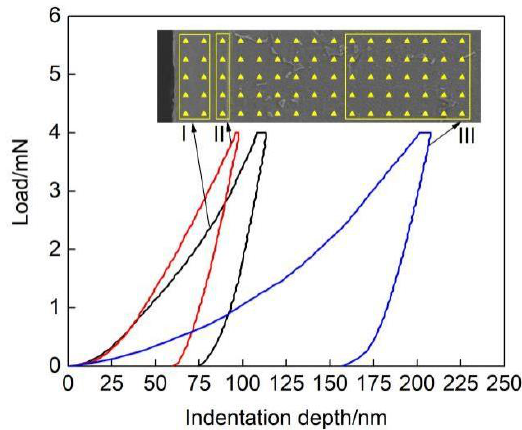
Figure 7. Average load-displacement curves of the Mo deposition layer, the initial part of the Mo diffusion layer and the TC4 substrate. diffusion layer and the TC4